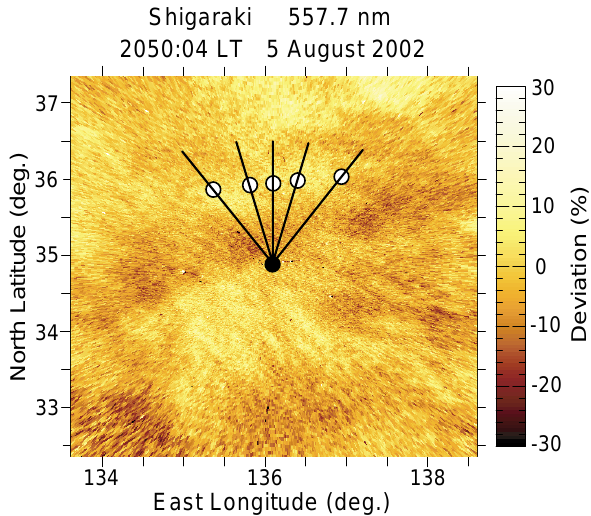
Fig. 3. Map of deviation of 557.7-nm airglow intensity ( 1I 558 ) taken at 20:50:04 LT on 5 August 2002. Position of Shigaraki (solid circle) and 5 MU radar beams (solid lines) are also shown. White circles represent positions where the beam penetrates 96km alti-